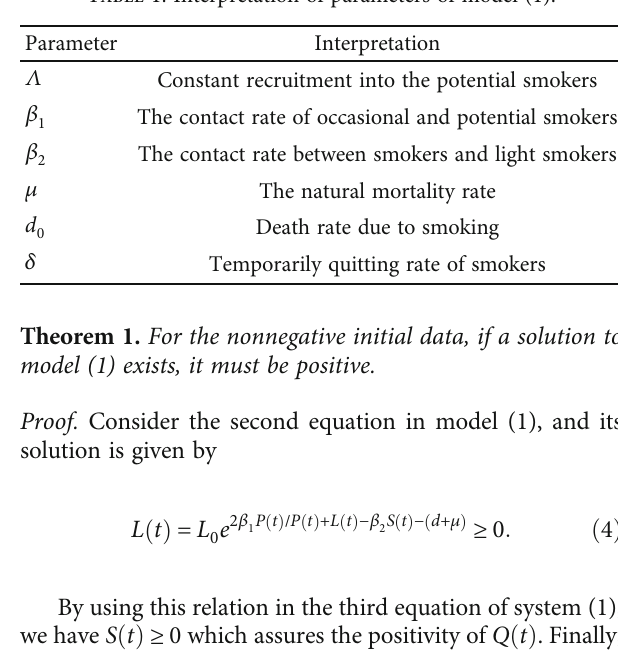
Table 1: Interpretation of parameters of model